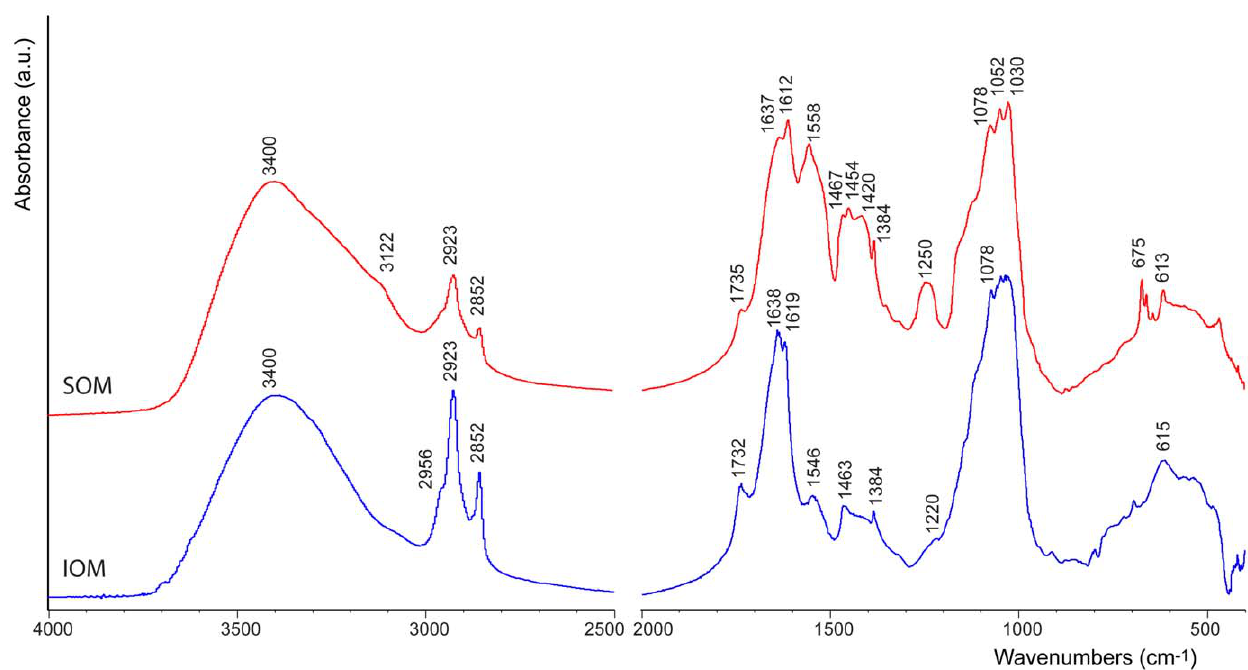
Figure 2. OM characterization. FTIR spectra of intra-skeletal soluble (SOM) and insoluble (IOM) organic matrix from the Balanophyllia europaea aragonitic skeleton. Typical absorption bands from protein molecules (around 1600 cm 2 1 ), polysaccharides (around 1000 cm 2 1 ) and lipids (around 2900 cm 2 1 ) are indicated. The absorption due to the polysaccharidic regions appeared stronger than the one due to the proteic regions in both the IOM and SOM spectra.